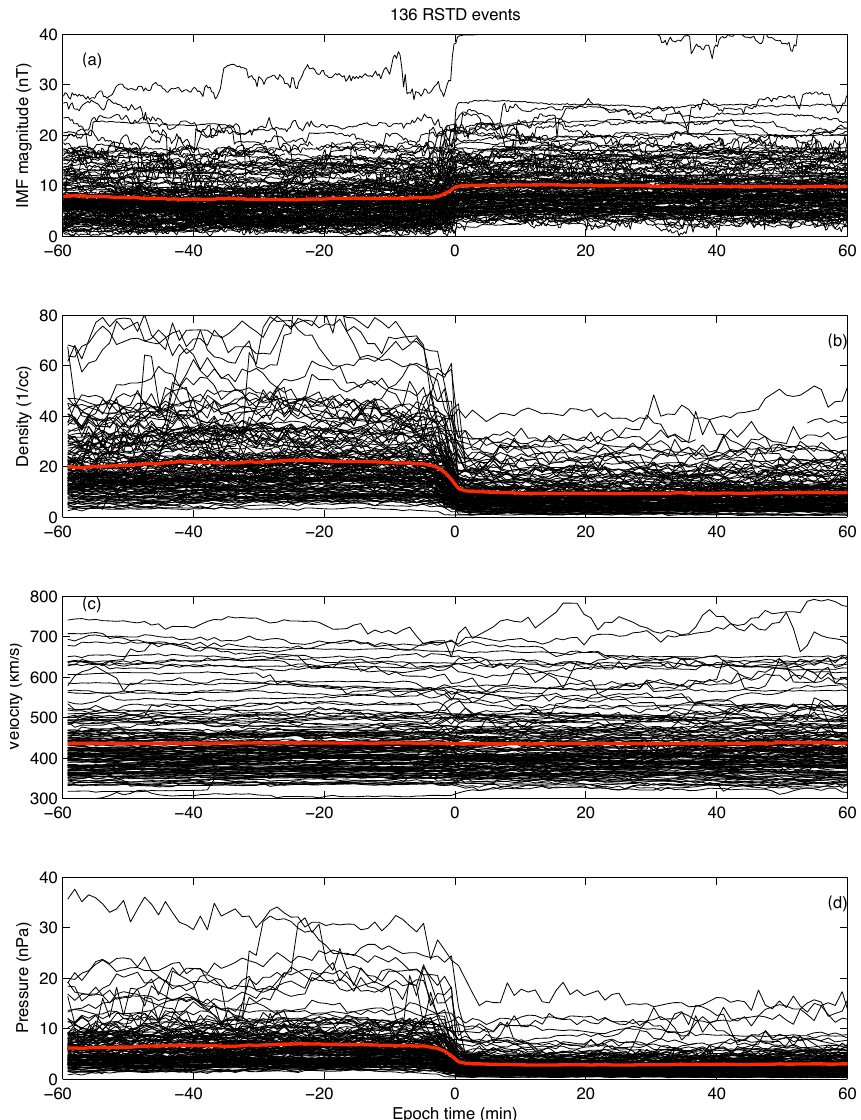
Fig. 2. Individual events (black) and the superposed epoch average (red) for the 136 sudden negative pressure pulses with a simultaneous increase in the IMF magnitude. (a) IMF magnitude, (b) solar wind density, (c) solar wind velocity, and (d) solar wind dynamics pressure.